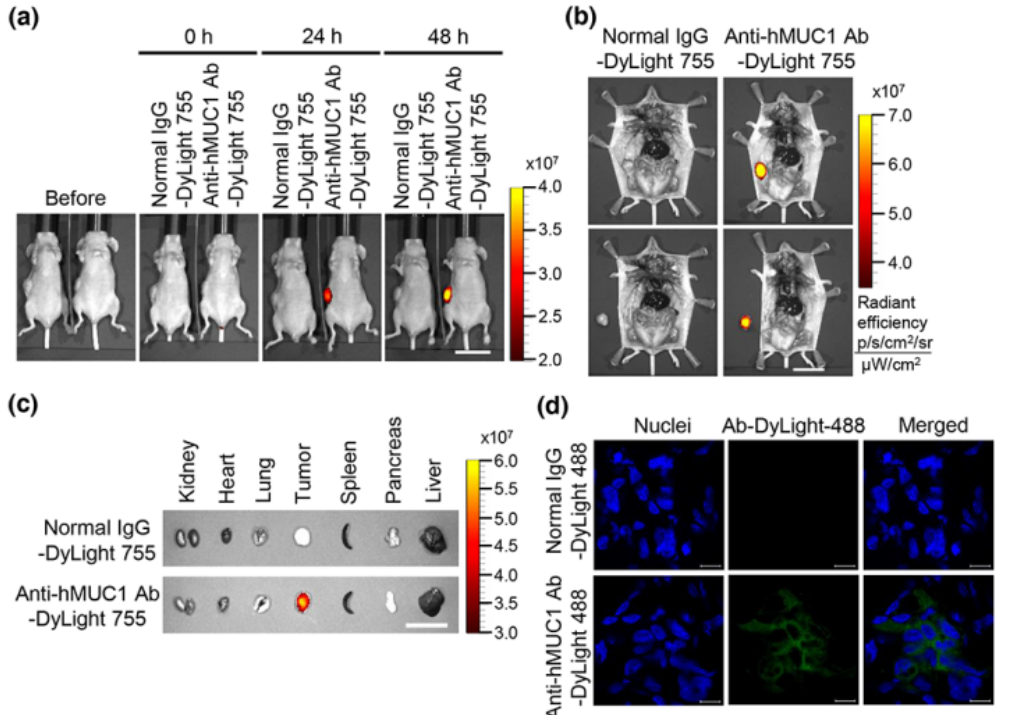
Figure 4. Biodistribution of anti ‐ hMUC1 monoclonal antibody in a xenograft mouse model. BALB/c nu/nu mice were subcutaneously inoculated with Capan ‐ 2 cancer cells to allow tumor formation. ( a ) DyLight 755 ‐ labeled normal IgG (5 mg/kg) or DyLight 755 ‐ labeled anti ‐ hMUC1 monoclonal antibody (5 mg/kg) were intravenously injected into mice, followed by acquisition of whole body fluorescent images at 0, 24 and 48 h using in vivo imaging system. ( b ) Upper panel: The localization of the antibody in the tumor region intact to mice. Lower panel: The localization of the antibody in the tumor region after dissection from the same mice. ( c ) Tumor tissues and organs were isolated and analyzed for the antibody distribution. Scale bars, 2.5 cm ( a – c ). ( d ) Confocal images of tumor sections obtained from mice intravenously injected with DyLight 488 ‐ labeled normal IgG or anti ‐ hMUC1 monoclonal antibody. The frozen tissues were cut into slices using a cryostat and stained with Hoechst 33258 for nuclei. The mounted samples were examined with confocal microscopy. Scale bars, 10 μ m ( d ). The images are representative of data from 3 sets of mice.